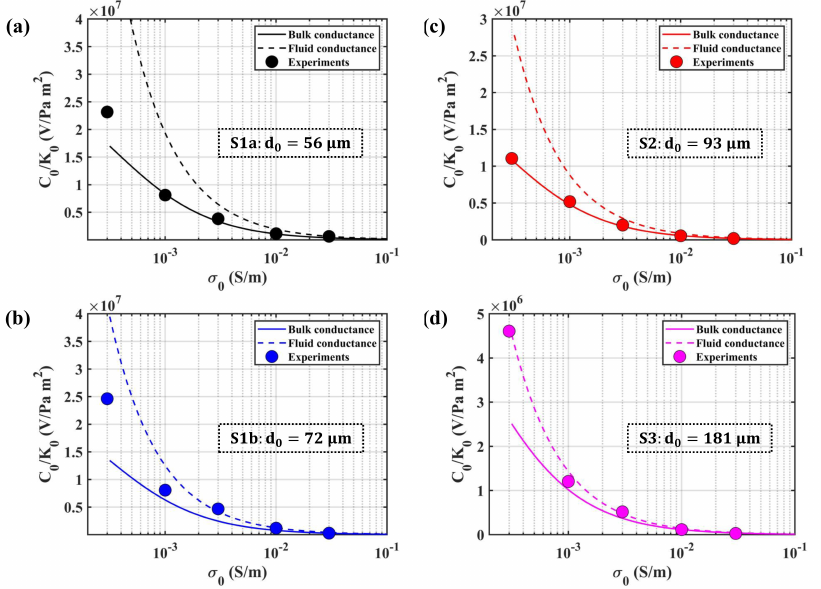
Figure 10. The influence of surface conductance on steady-state SPC. ( a ) reduced steady SPC C 0 / K 0 for Sample S1a with the mean diameter as d 0 = 56 µ m; ( b ) reduced steady SPC C 0 / K 0 for sample S1b with the mean diameter as d 0 = 72 µ m; ( c ) reduced steady SPC C 0 / K 0 for sample S2 with the mean diameter as d 0 = 93 µ m; ( d ) reduced steady SPC C 0 / K 0 for Sample S3 with the mean diameter as d 0 = 181 µ m.